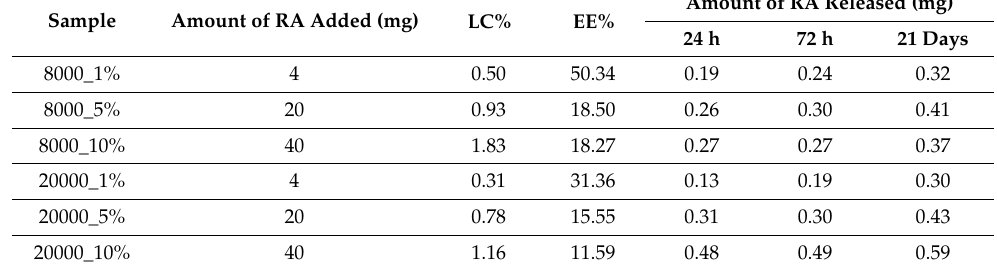
Table 3. The amount of RA added, the LC% and EE%, and the amount of RA released at specific time points for the drug delivery systems.